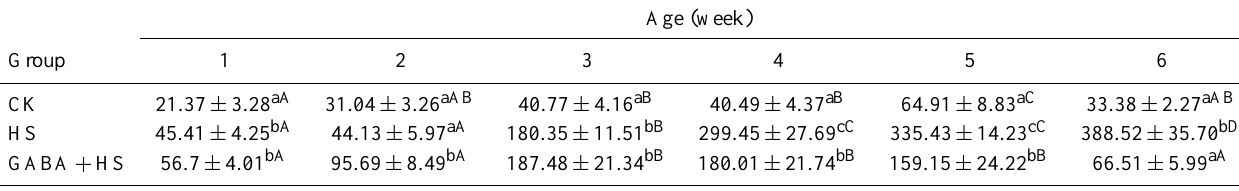
Table 2. The effect of GABA on the density of apoptosis in the BF of chicks under heat stress.